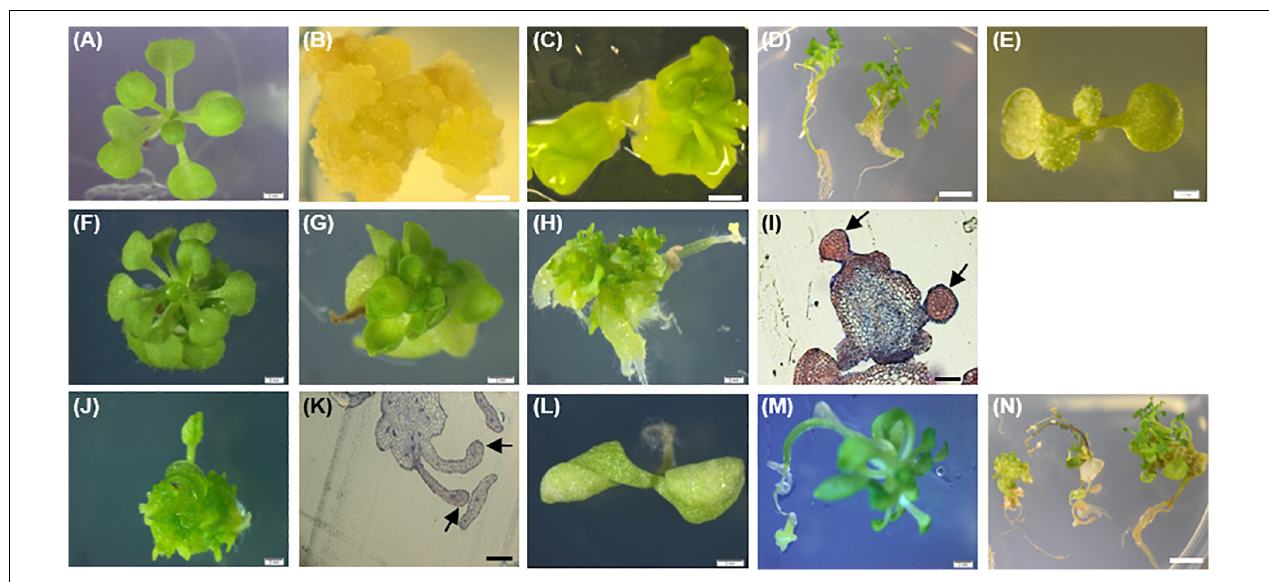
FIGURE 8 | Phenotypes of the 35S::PpWOX2 transgenic plants, transgenic EV-pC05, and non-transgenic WT control plants of Arabidopsis . (A) WT seedling from first (T 1 ) or second (T 2 ) generation grown in MS medium without PGRs for 7 weeks. (B) WT non-embryogenic callus. (C) WT SEs obtained from explants of immature zygotic embryos cultivated in an induction medium (B5 medium supplemented with 5 µ M 2,4-D) after 4 weeks. (D) WT SEs germinated and developed into somatic plants in MSR medium after 2 weeks. (E) EV-pC05 transgenic plant (transformed with the pCAMBIA1305.2 empty vector) grown in MS medium supplemented with 20 mg l − 1 hygromycin. These control plants exhibited a normal phenotype similar to that of WT seedlings (A) in both T 1 and T 2 generations. PpWOX2 -transformed seeds of the T 1 generation germinated in MS medium supplemented with 20 mg l − 1 hygromycin and exhibiting (F) normal growth, (G) stunted growth, (H) embryo-like structures, or (J) leaf-like structures. Histological aspects of (I) embryo-like structures and (K) leaf-like structures (arrows) were analyzed after staining with Ponceau-methylene blue. The T 2 generation of PpWOX2 transgenic seeds developed into plants with (F) normal growth, (G) stunted growth, (L) two cotyledons, or (M) root tips forming embryo-like structures. (N) Embryo-like structure from the PpWOX2 T 1 plant generation converted into somatic plants in MSR medium. Scale bars: (B,C,H,J) , and (L) 0.5 mm; (A,E,F,G) 1 mm; (D,N) 1.2 mm; and (I,K) 0.2